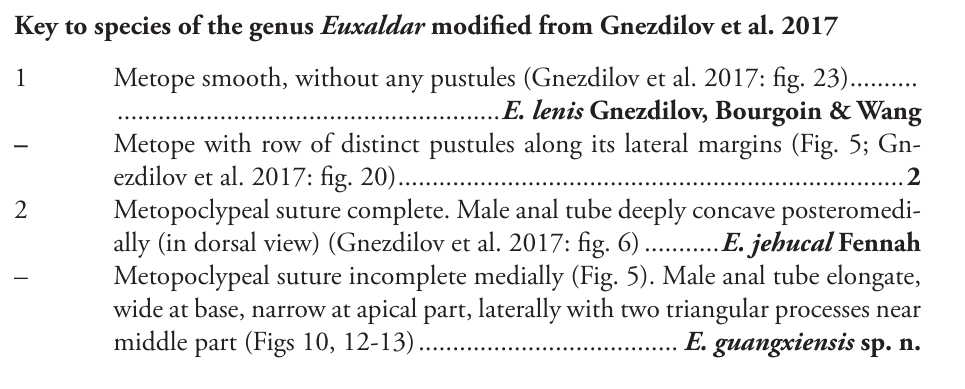
Type material. Holotype: 1 ♂ , China: Guangxi, Nonggang National Nature Reserve (E106°58'3", N22°28'37"), 163 m, 29 Oct. 2017, K.K. Liu Description. Body length (from apex of vertex to tip of forewing): male 3.8mm; Forewing: male